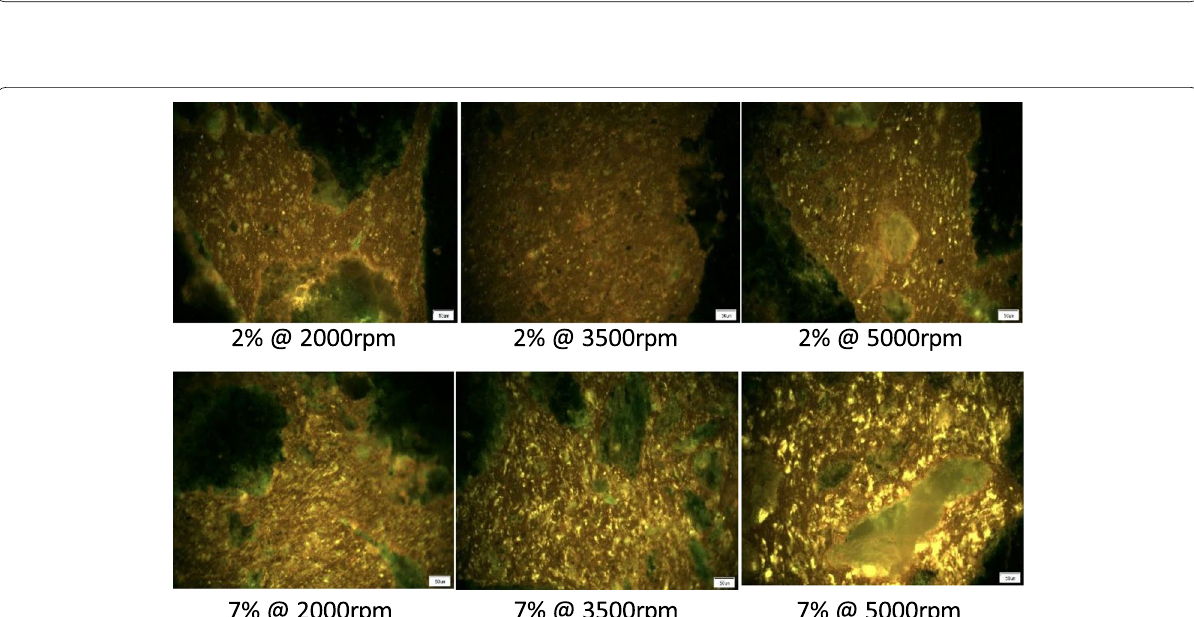
Fig. 11 Fluorescence images of SBS modifier in mixtures at a different shearing rate (image size: 1.4 mm